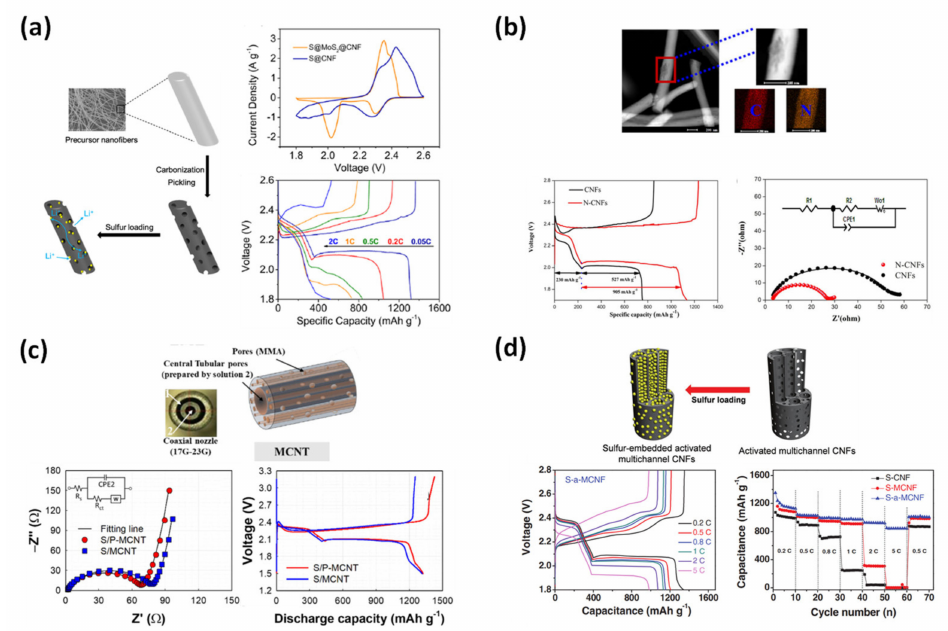
Figure 14. ( a ) Porous CNFs embedded with sulfur applied for lithium − sulfur batteries [101]. ( b ) CNFs contain MOF material for nitrogen function group doping [103]. ( c ) Porous, hollow multi- channel CNFs for lithium-sulfur battery [104]. ( d ) Multichannel porous CNFs using KOH-treatment process embedded with sulfur